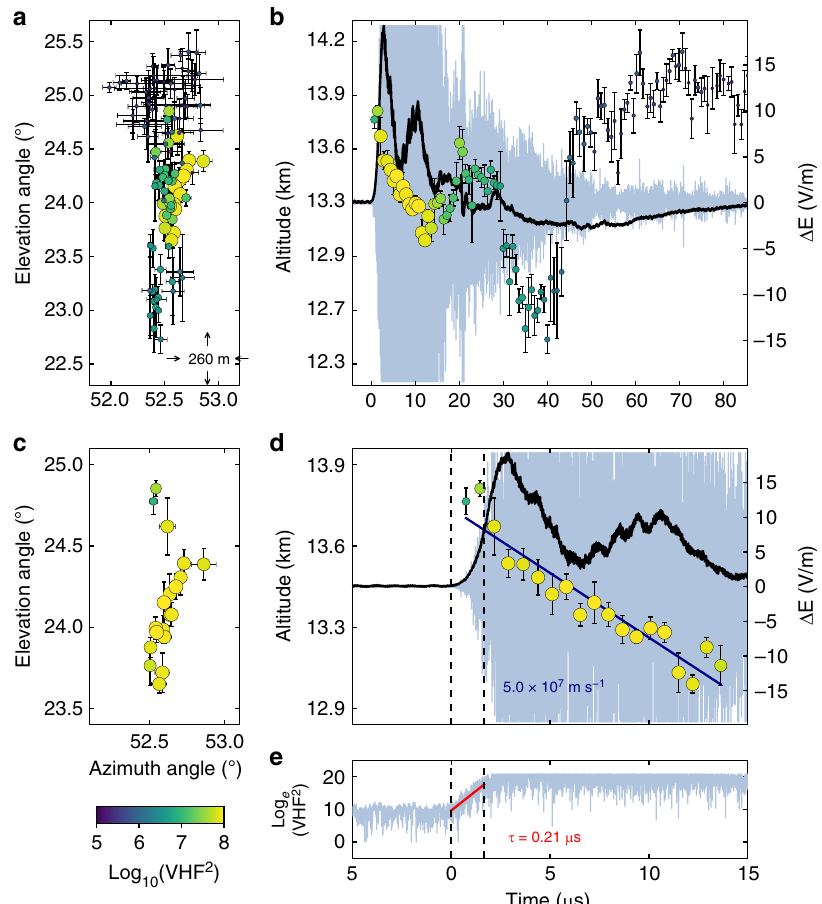
Fig. 2 Interferometer data for NBE 1. a , c Radiation centroids (circular markers, colored and sized by VHF power) for NBE 1, plotted in elevation vs. azimuth, showing the breakdown activity was primarily vertical. Each marker denotes the average angular position of the 128 source solutions in each 0.7- μ s window, and error bars denote the standard deviations. b , d Radiation centroids and fast electric fi eld change (sferic) observations (black waveform) superimposed on the VHF waveform (gray), showing the downward propagation of the VHF source. The positive sferic waveform is indicative of a downward-directed current, consistent with the NBE occurring below the storm ’ s upper positive charge, and indicating the downward development was due to positive-polarity breakdown. The breakdown descended ≃ 600 m in 13 μ s, corresponding to a speed of ≃ 5 × 10 7 m s − 1 . e Semilog plot of the VHF power vs. time, showing the fast exponential rise of the radiation (rise time τ = 0.21 μ s), coincident with the fast rise of the electric fi eld change ( d ). The peak current of the breakdown was − 75